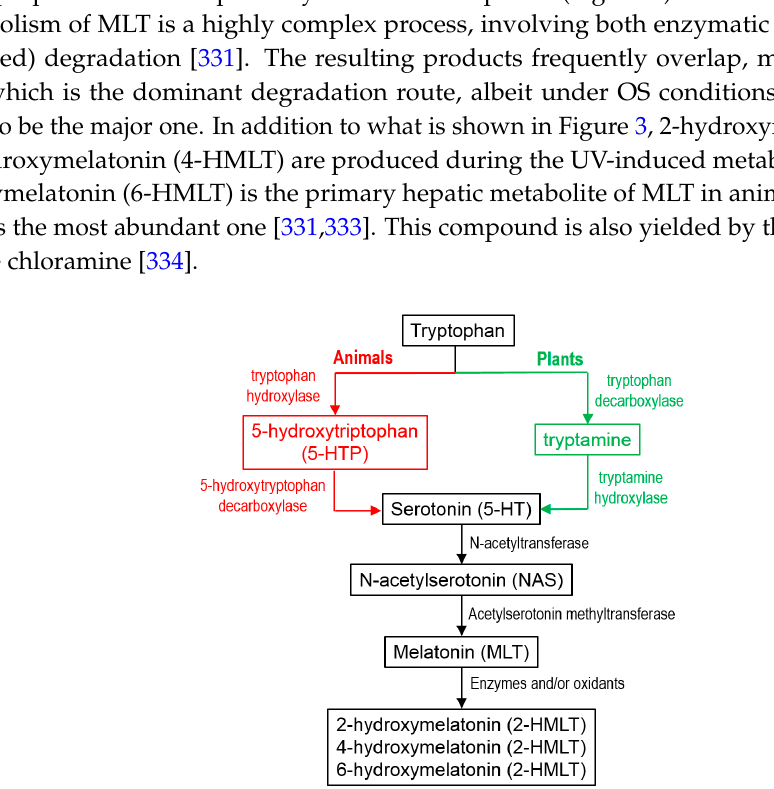
Figure 3. Schematic representation of the metabolic route connecting the naturally occurring phenolic melatonin-related compounds. Enzymes include cytochrome P450 (CP450), horseradish peroxidase (HRP), indoleamine 2,3-dioxygenase (IDO), eosinophil peroxidase (EPO), myeloperoxidase (MPO) and melatonin 2-hydroxylase (M2H). Oxidants include ROS and